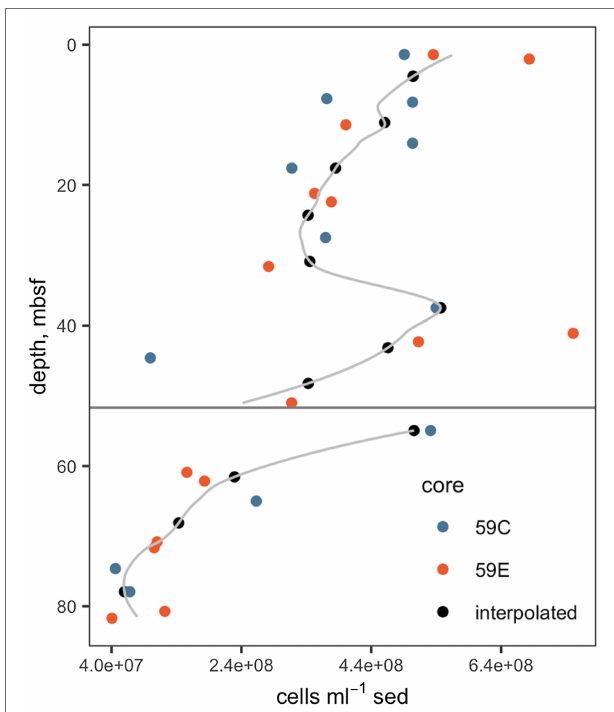
FIGURE 2 | Cell abundances. Data from cores 59C and 59E were used in order to improve the precision of the interpolation. The gray line indicates the full interpolation, and the black points indicate the interpolated cell counts at depths at which enzyme activities were measured. The horizontal gray line indicates the unconformity. Underlying cell count data are from Buongiorno et al., (2017).